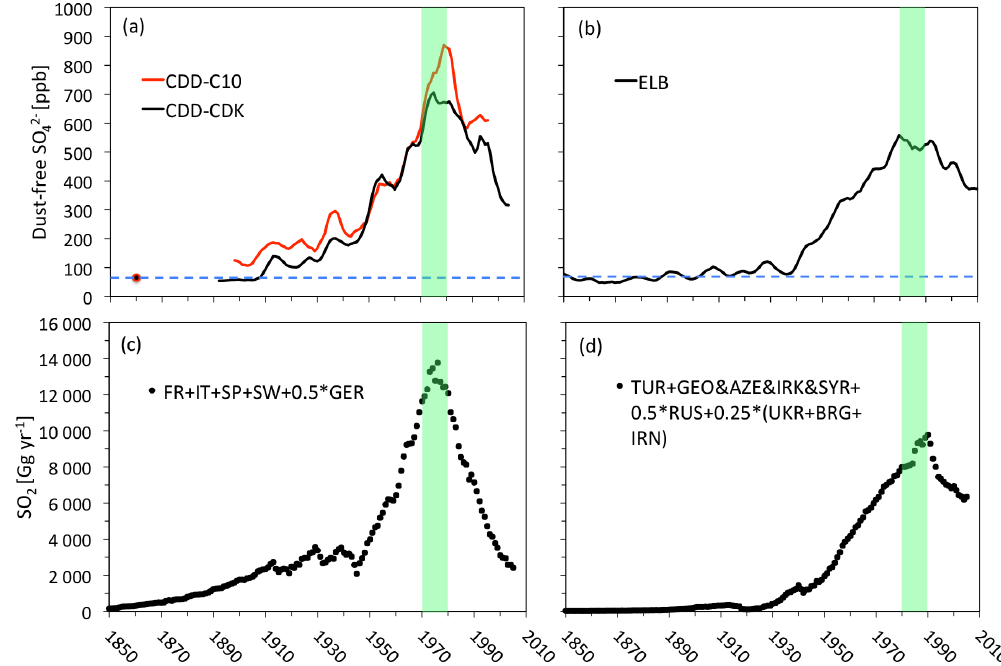
Figure 13. Comparison of the dust-free sulfate summer trends (SO 2 − values) from two CDD ice cores (C10 and CDK) (a) and the ELB 4 red . ice core (b) with SO 2 emissions from countries suspected to contribute to sulfate depositions at the two sites ( c for CDD, d for ELB; see discussions in Sect. 5.2). (a, b) Solid lines refer to the first SSA component with a 5-year time window. Horizontal dashed blue lines refer to the respective pre-industrial sulfate levels. (c) SO 2 emissions from France, Italy, Spain, Switzerland, and half from Germany. (d) SO 2 emissions from Turkey, Georgia, and Azerbaijan; half from Russia; and a quarter from Ukraine, Bulgaria, and Iran. Green areas indicate the decades in which the sulfate levels reached their